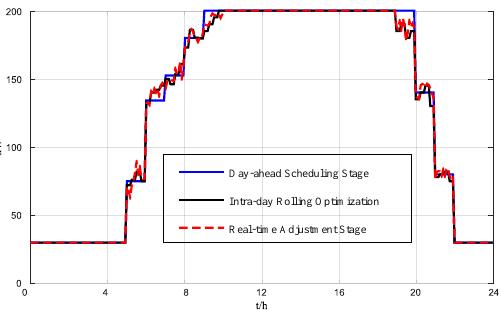
Figure 6. Electric power output of the microgas turbine at multiple time scales.